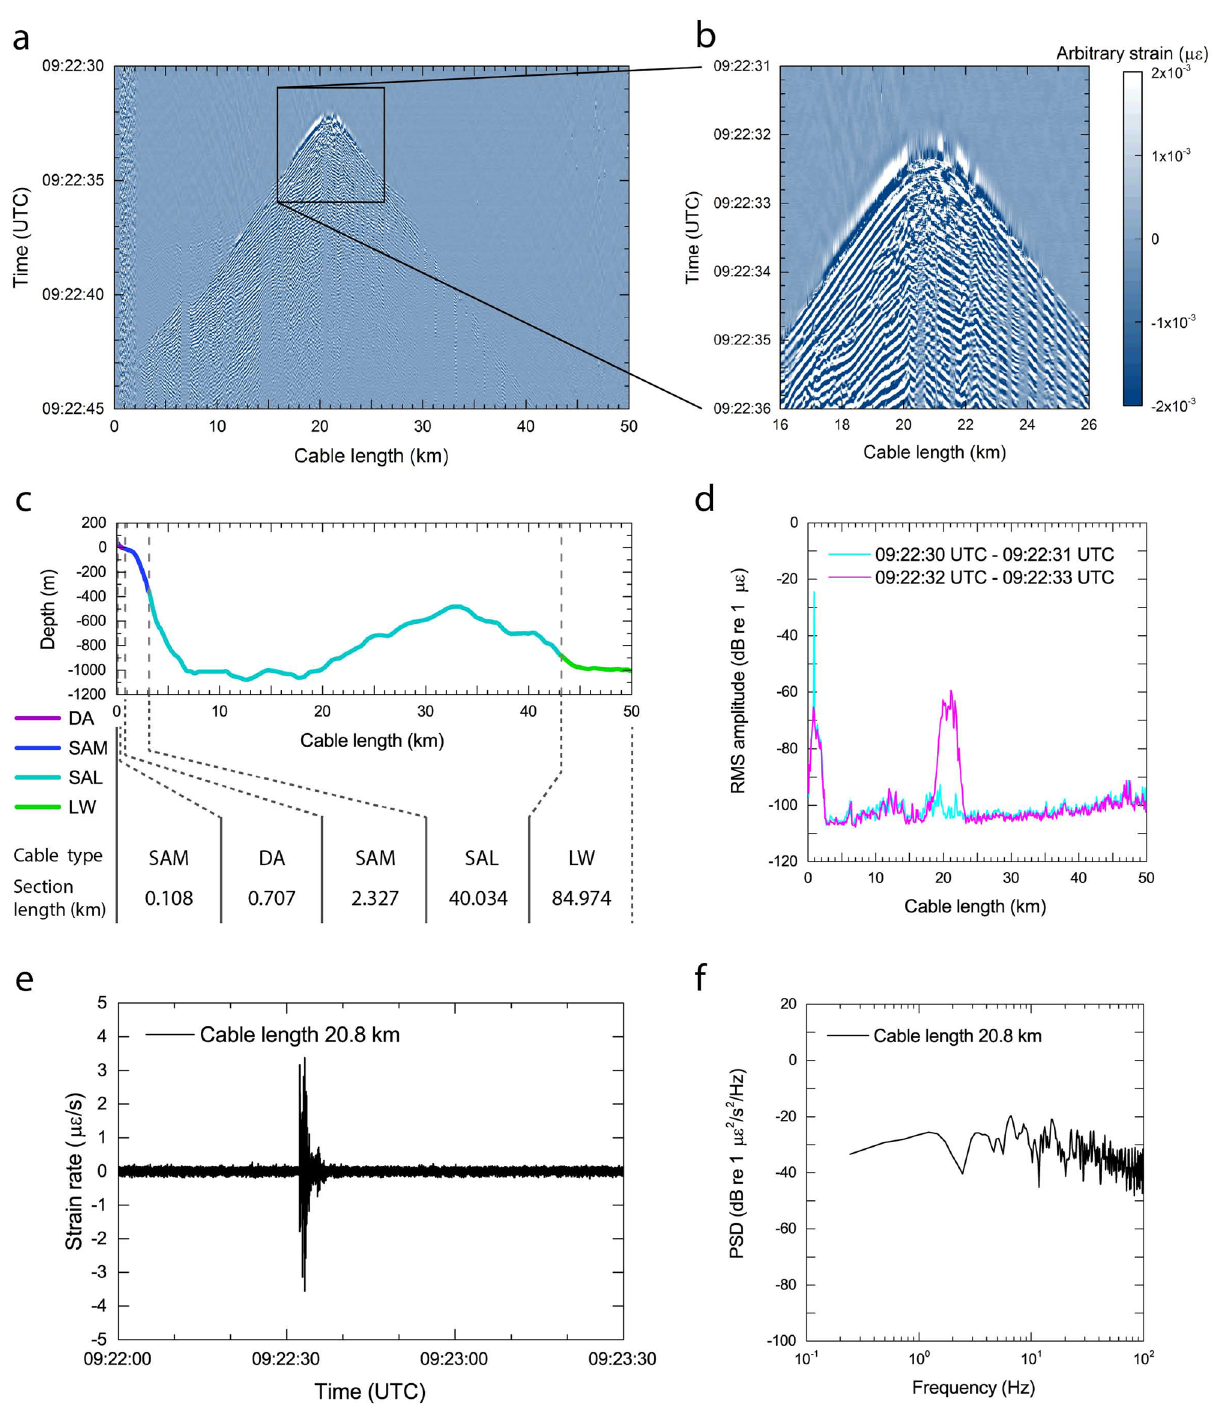
Figure 2. An example of the DAS recordings associated with the air-gun shot. The air-gun shot presented is number 1675 along the MR01 line indicated in Fig. 1c. ( a ) 15 s-long recording (a period for 09:22:30 UTC to 09:22:45 UTC on 03 December 2019) of strain along the Muroto cable up to 50 km. A band-pass filter between 2 and 60 Hz is applied to the strain dataset. ( b ) Enlarged figure focusing on the first arrival of the hydroacoustic signal at a cable section between 16 and 26 km. Periodic strain fluctuations are observed on both sides of the arrival. ( c ) Cross-sectional profile along the Muroto cable with information of submarine cable type. Cable types of DA, SAM, SAL, and LW mean double armored, single armored medium, single armored light, and light weight cables, respectively. ( d ) Root-mean-square (RMS) amplitudes along the Muroto cable. RMS amplitudes are calculated using 100-m bins. Two different periods between 09:22:30 UTC and 09:22:31 UTC and between 09:22:32 UTC and 09:22:33 UTC are presented. The former and the latter RMS amplitudes are associated with the ambient noise and the air-gun shot, respectively. ( e ) Time series of strain rate recording the air-gun shot at a cable length of 20.8 km. ( f ) Power spectral density (PSD) of strain rate associated with the air-gun